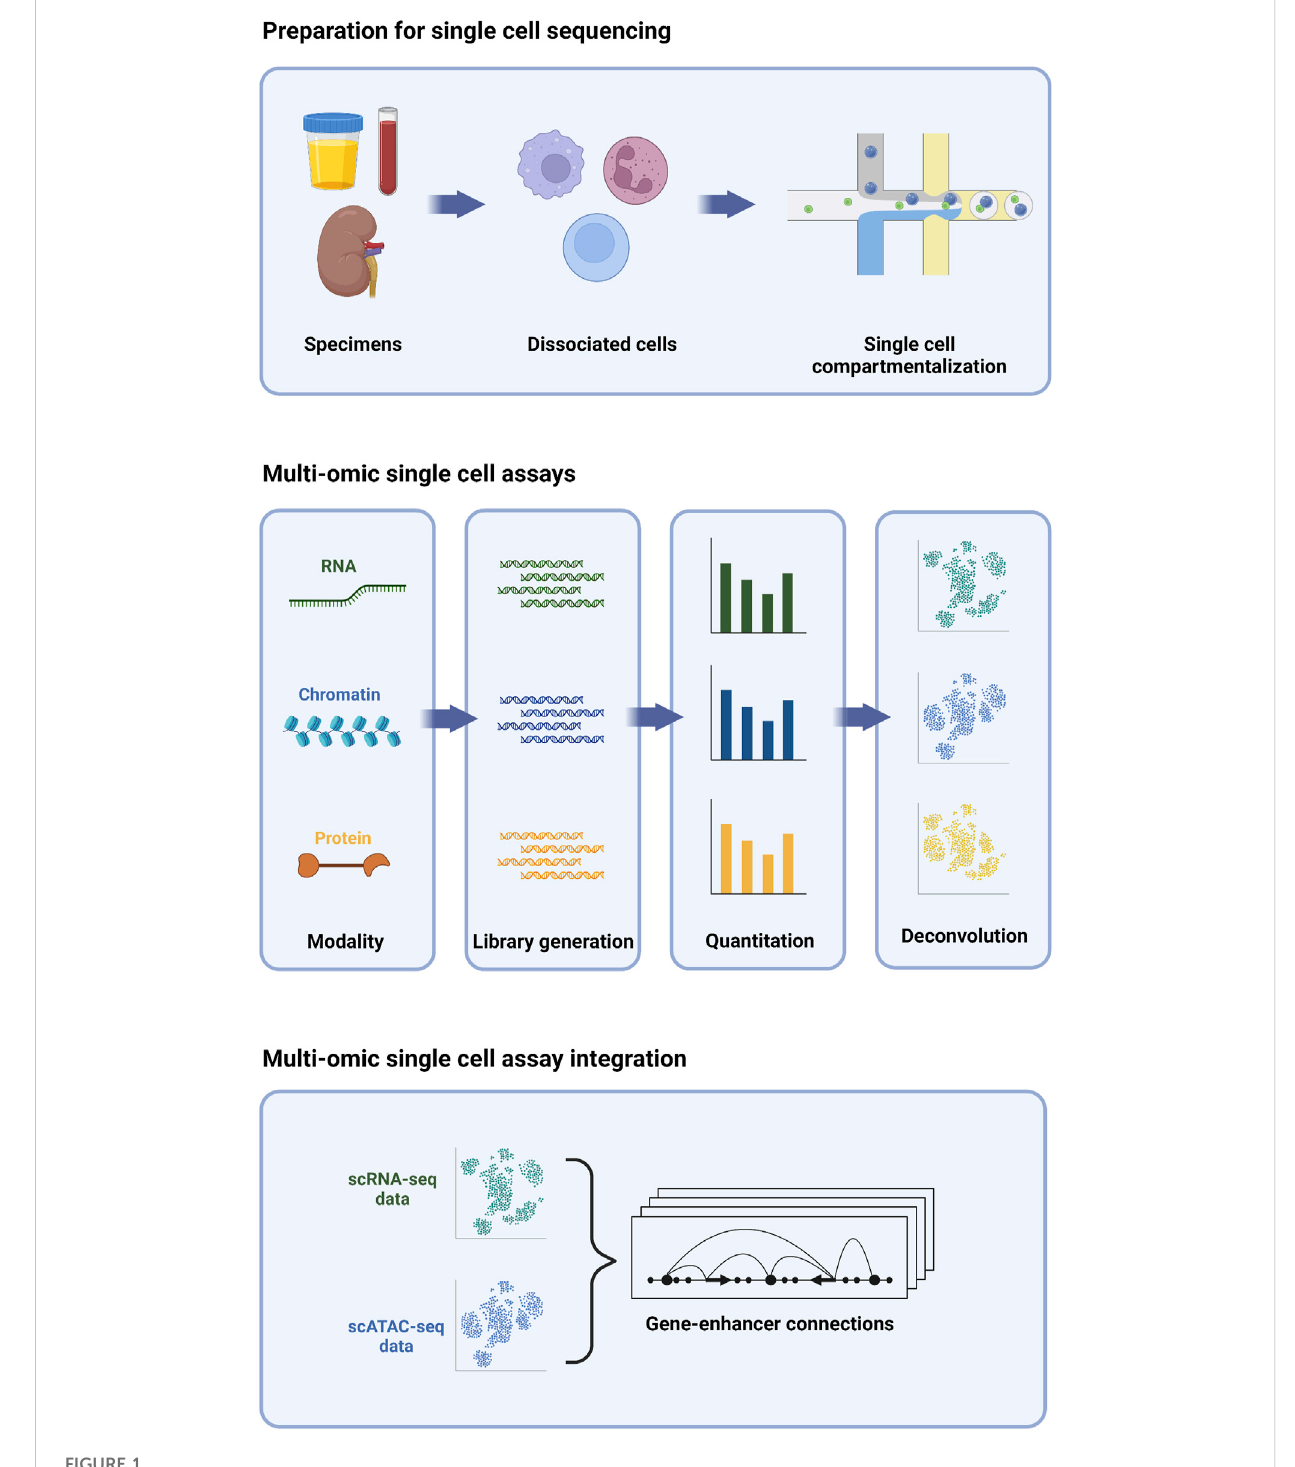
FIGURE 1 Multi-omic single cell sequencing provides an integrated view of cell biology from heterogeneous tissue sources.